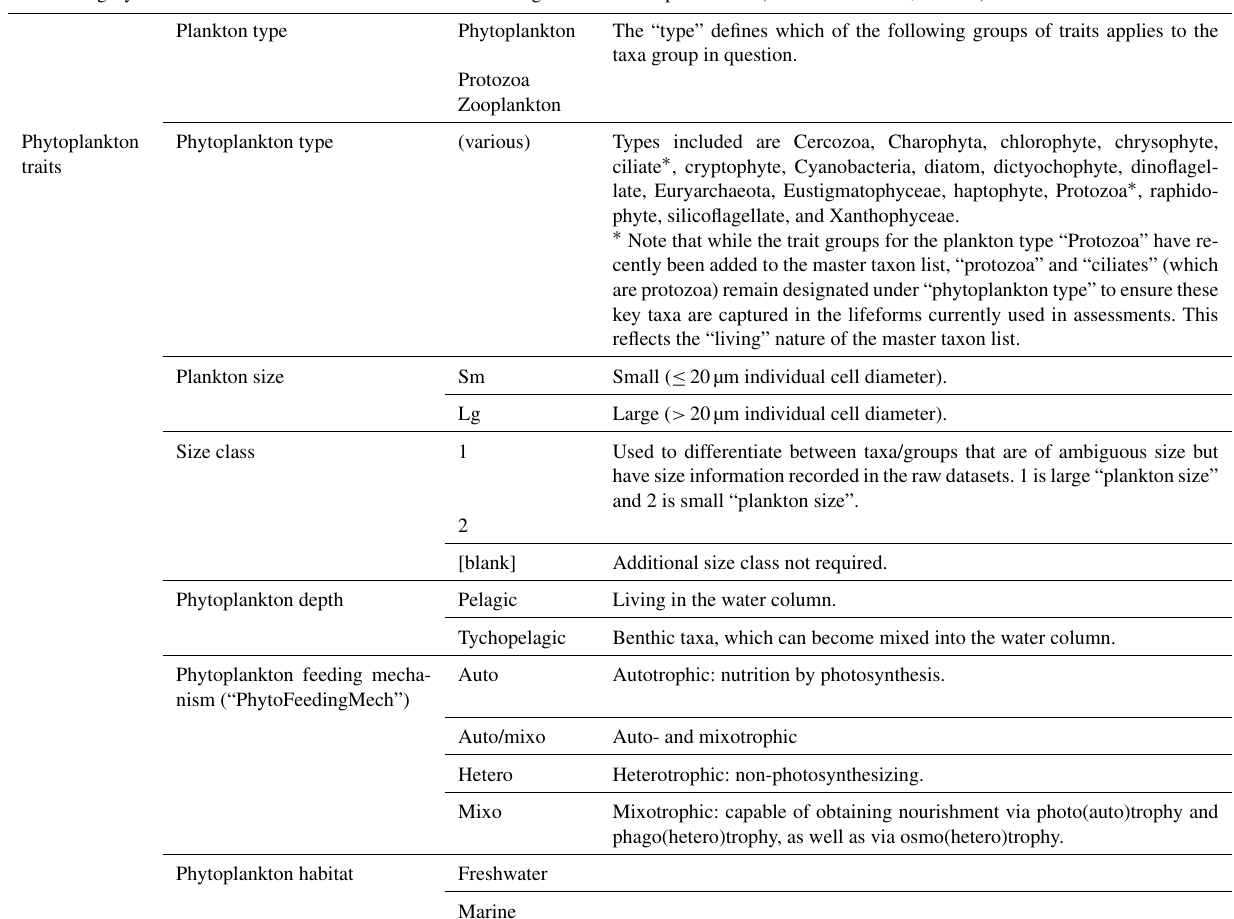
Table A1. Relevant trait in lifeform traits list. The trait list reflects the lifeforms and types of plankton data in the datasets used to date in lifeform-based assessment. The list is a living document, whose status reflects ongoing efforts to refine and improve the lifeform approach as well as a necessary compromise between focusing on traits which inform the lifeforms currently used for assessments and including additional information and traits where these are known and readily available. Trait groups for the plankton type “Protozoa” have recently been added to the trait list but are not shown here as they are not finalized and not used in any of the current lifeforms. The inclusion of “protozoa” and “ciliates” (which are protozoa) designation under “phytoplankton type” is to ensure these key taxa are captured in lifeforms. One important example is the abundant group “Flagellates” which has “Plankton type: phytoplankton” to allow assignment of the phytoplankton trait groups, despite including both phototrophic and heterotrophic taxa and thus Phytoplankton type: protozoa. In the trait list: spaces between words are omitted, e.g. “Plankton type” is written as “PlanktonType”, and zooplankton is often abbreviated as “Zoo”. For all trait categories, “Y” is yes (trait applies) and “N”: no (trait does not apply). The following definitions apply to all columns (trait categories) of the list, with additional details given in the table where relevant: (1) “Ambiguous”: taxa cannot be reliably assigned to any one category for this trait, mostly because taxa within this group can fall under more than one trait category (e.g. taxa categories which include individuals of both “large” and “small” size classes); (2) “[blank]”: trait is not used for this plankton type (e.g. “PhytoHabitat” is blank for all zooplankton taxon groups); (3) “n/a”: (not applicable) trait is used for this plankton type but not relevant for this taxon (e.g. the line “fish larvae” has a “ZooHabitat” of NA because they are neither meroplankton nor holoplankton; the line is intended to only contribute to the “fish larvae” lifeform); (4) “NYA”: (not yet assigned) trait is used for this plankton type but is not yet assigned (e.g. phytoplankton which have not been assigned “tychopelagic”, “pelagic”, or “ambiguous” under